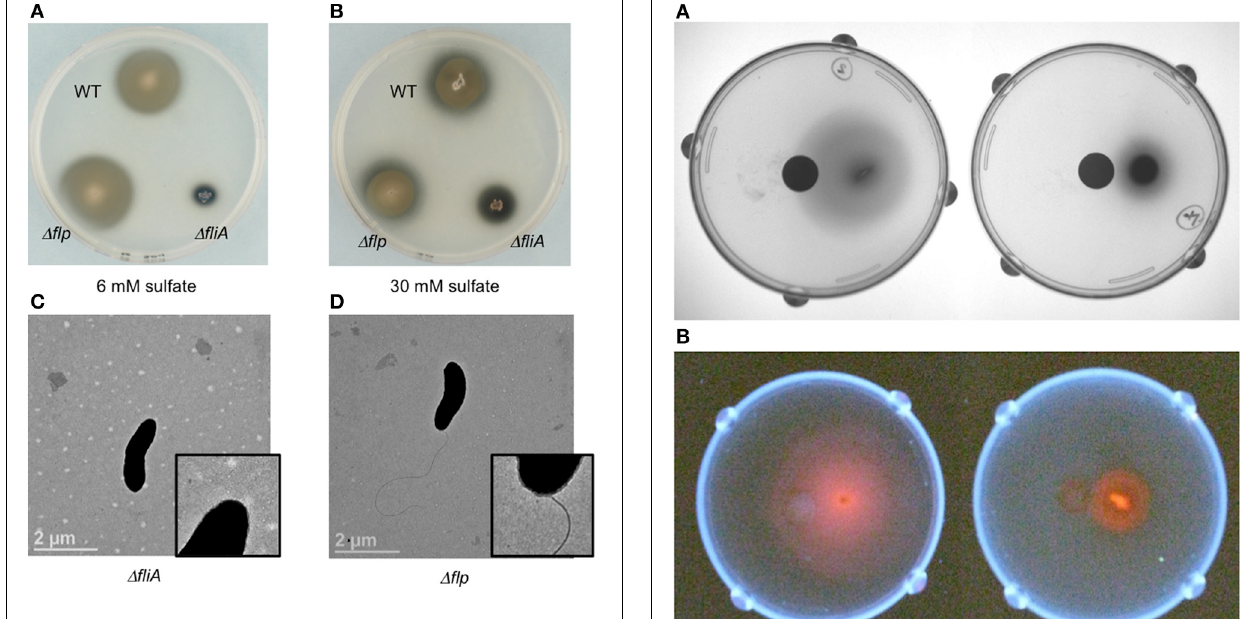
FIGURE 3 | Soft agar plate assays (0.4% agar wt/vol) of D. vulgaris wild type, JW9017 ( (cid:2) fliA) , and JW9003 ( (cid:2) flp ) in defined LS4D medium with 6mM sulfate (A) or 30mM sulfate (B). TEM images of JW9017 (C) and JW9003 (D) grown in defined LS4D medium show the presence of flagellum in the JW9003 strain but not in the JW9017 strain. Inset enlarged views are provided to indicate the flagellum clearly. Note: In rich media, a few cells in JW9017 show the presence of a shorter flagellum ( Figure S4 ).